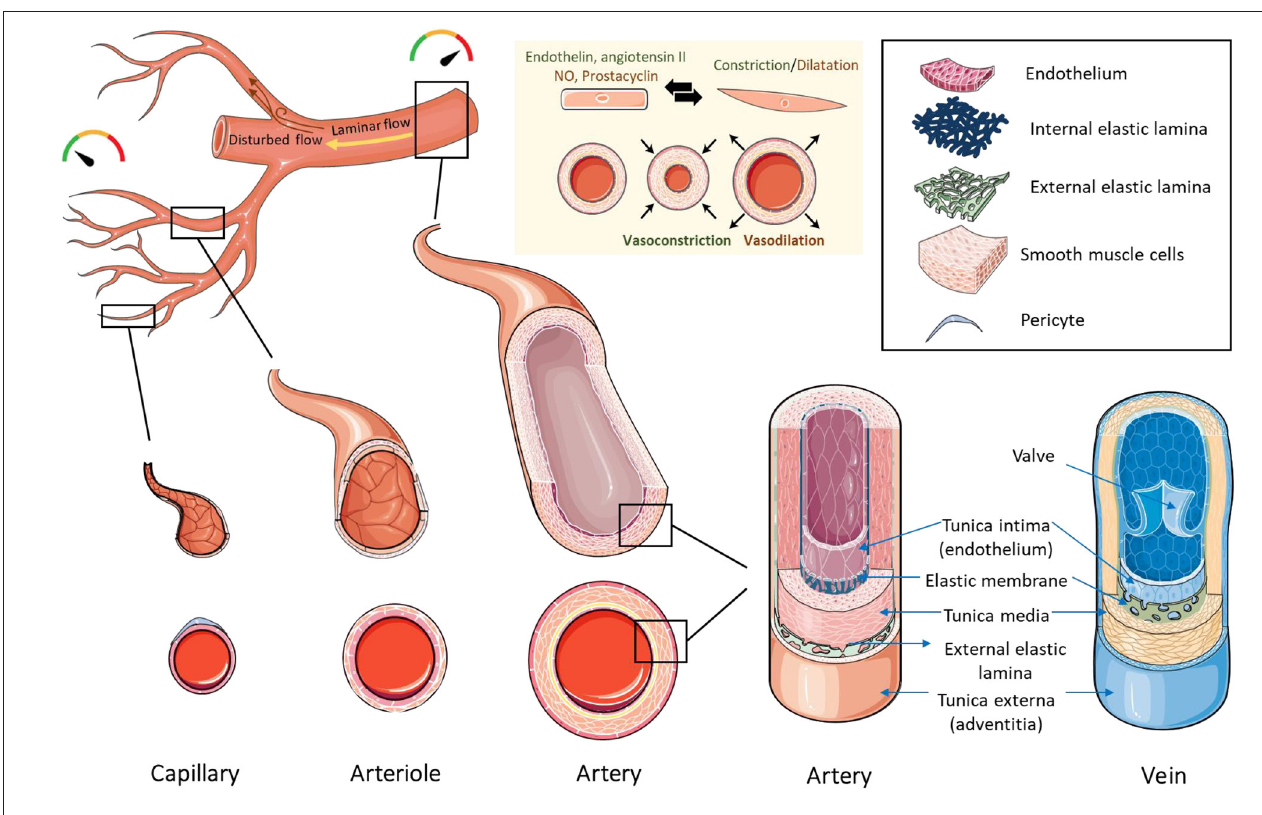
FIGURE 4 | Structure of blood vessels. Capillaries have the smallest diameter and are composed of an endothelial cell layer surrounded by pericytes. Arterioles and venules are larger in caliber than capillaries and contain an endothelial layer surrounded by a few smooth muscle cells. Arteries and veins have a thick layer of smooth muscle cells and extracellular matrix in the tunica media, lined by a layer of endothelial cells in the tunica intima. Arteries and veins contain an internal elastic membrane between the tunica media and tunica intima. Arteries contain an additional external elastic lamina between the tunica media and tunica adventitia. The blood flows from the major arteries where pressure is high to small blood vessels and veins where the pressure is low. The directionality of blood flow varies according to vessel geometry. Areas of uniform geometry have unidirectional/laminar flow, while areas of branches, curves, and bifurcations, have non-directional/disturbed flow. Blood vessels control the pressure/flow of blood by changing their vascular tone. Vascular tone is maintained by the release of vasoconstrictors (such as endothelin and angiotensin II) or vasodilators (such as nitric oxide and prostacyclin) by the endothelial cell layer, which influences the constriction or dilation of smooth muscle cells, leading to vasoconstriction or vasodilation. Created using Servier Medical ART: SMART